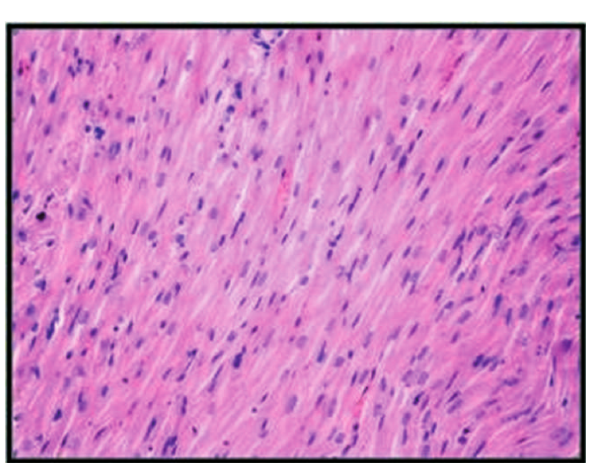
Fig. 2 - Estudo histopatológico demonstrando tecido miocárdico com alterações histológicas leves (Grau 1)